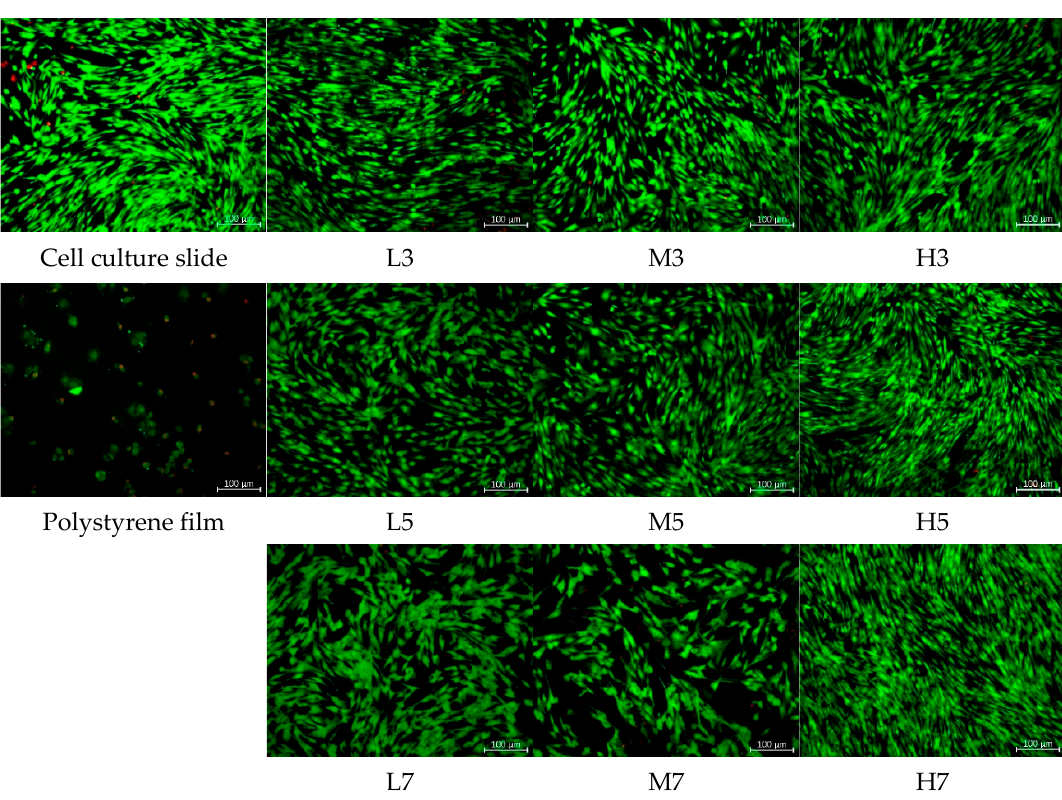
Figure 9. Live/dead cell assay images obtained under a fluorescent microscope (combining a green and red filter). Cells adhered and proliferated on the GO coated on polystyrene film, confirming zero cytotoxicity.